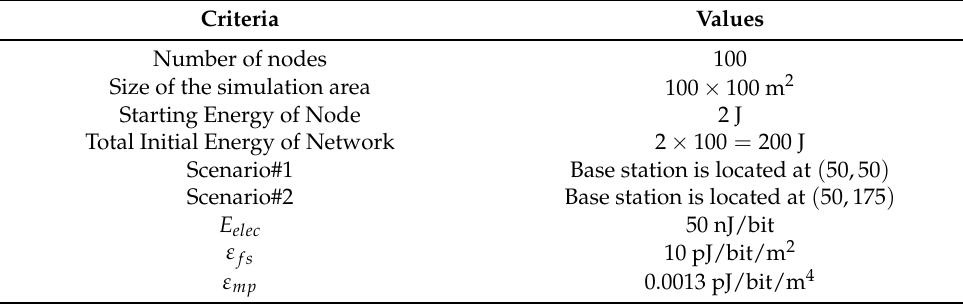
Table 2. Network Simulation Setup.